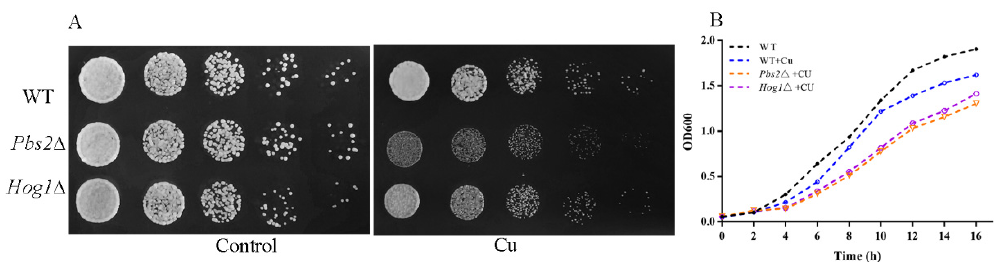
Figure 2. The HOG pathway is important for protecting yeast cells against copper-induced stress: ( A ) Spot assay of Wild-type (WT) strains, Pbs2 ∆ , and Hog1 ∆ .WT, Pbs2 ∆ , and Hog1 ∆ strains were spotted on YPD plates under normal and 4 mM CuSO 4 treatment conditions. Each strain was grown to the log phase in YPD broth and serially diluted 5-fold from an initial OD600 of 0.1. Aliquots (5 µ L) were spotted onto a YPD agar plate lacking or containing 4 mM CuSO 4 and incubated at 28 ◦ C for 1–2 days. ( B ) Growth kinetics of WT strains, Pbs2 ∆ , and Hog1 ∆ . Yeast cultures grown on liquid YPD medium (WT) or YPD containing 4 mM CuSO 4 (WT + Cu, Pbs2 ∆ + Cu, and Hog1 ∆ + Cu) were incubated at 28 ◦ C for 16 h with slow